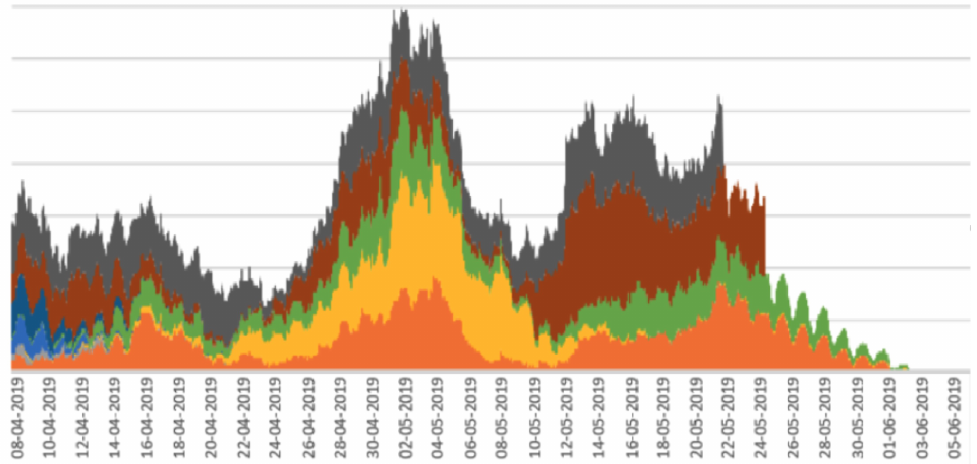
Figure 8. Stacked line graph for aligned periodicity intensities for calves 11–19. Each colour represents a different